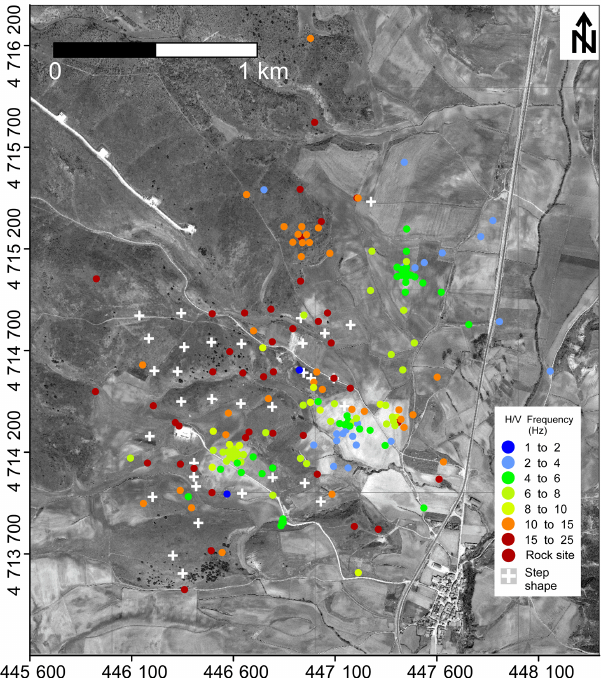
Figure 10. H / V method. Fundamental H / V peak frequencies over the study area (colour coded). White crosses denote stations with step morphology (Fig. 9). Map is shown in UTM coordinates in m, ETRS89